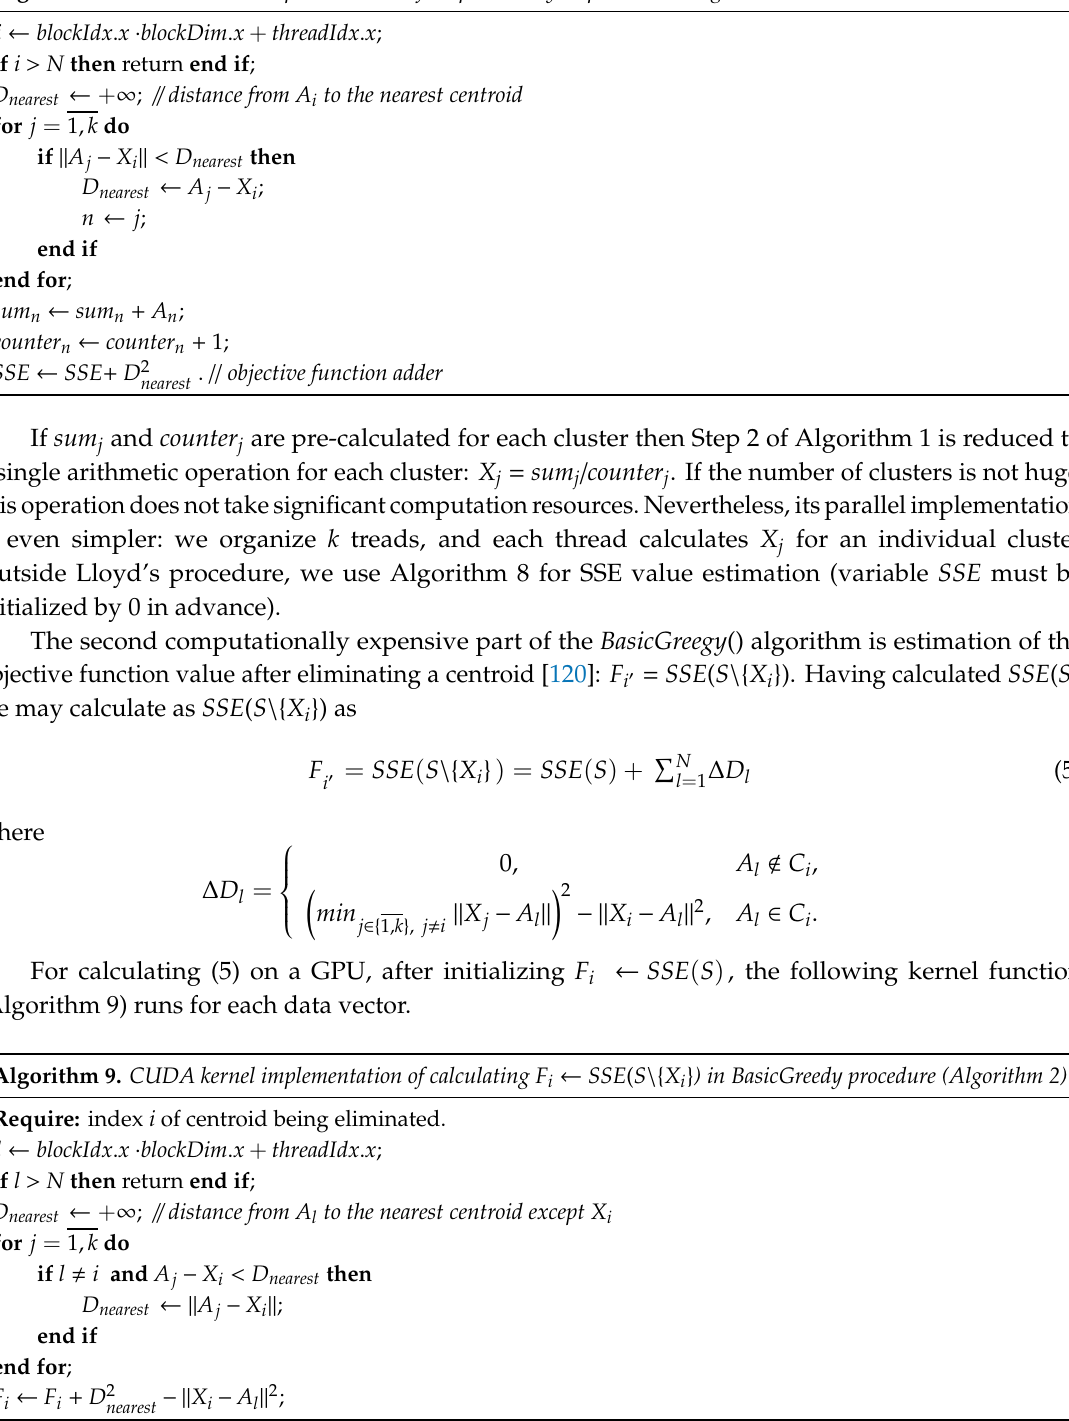
Algorithm 8. CUDA kernel implementation of Step 1 in Lloyd’s procedure (Algorithm